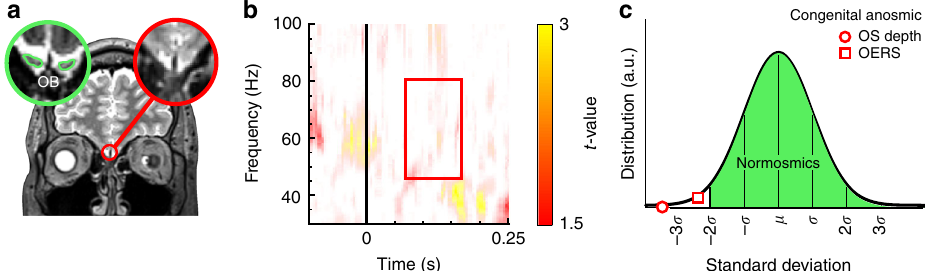
Fig. 5 Lack of EBG from one individual ( n = 1) with isolated congenital anosmia (ICA) missing both OBs. a Coronal view of T2-weighted image of the brain of an individual with ICA, lacking bilateral OB (marked with red). In the left corner is an example of OB from a healthy individual using identical MR examination with the green outline in the green circle delineating the OB. b Monte Carlo permutation test with 1000 permutations demonstrating no change in the OERS signal between Odor vs. Air. c Distribution of EBG power for the normosmic cohort from Study 1 represented by the green area, the observed sulcus depth (OS) and OB power (OERS) of the individual with isolated congenital anosmia is represented by an open red circle and square,